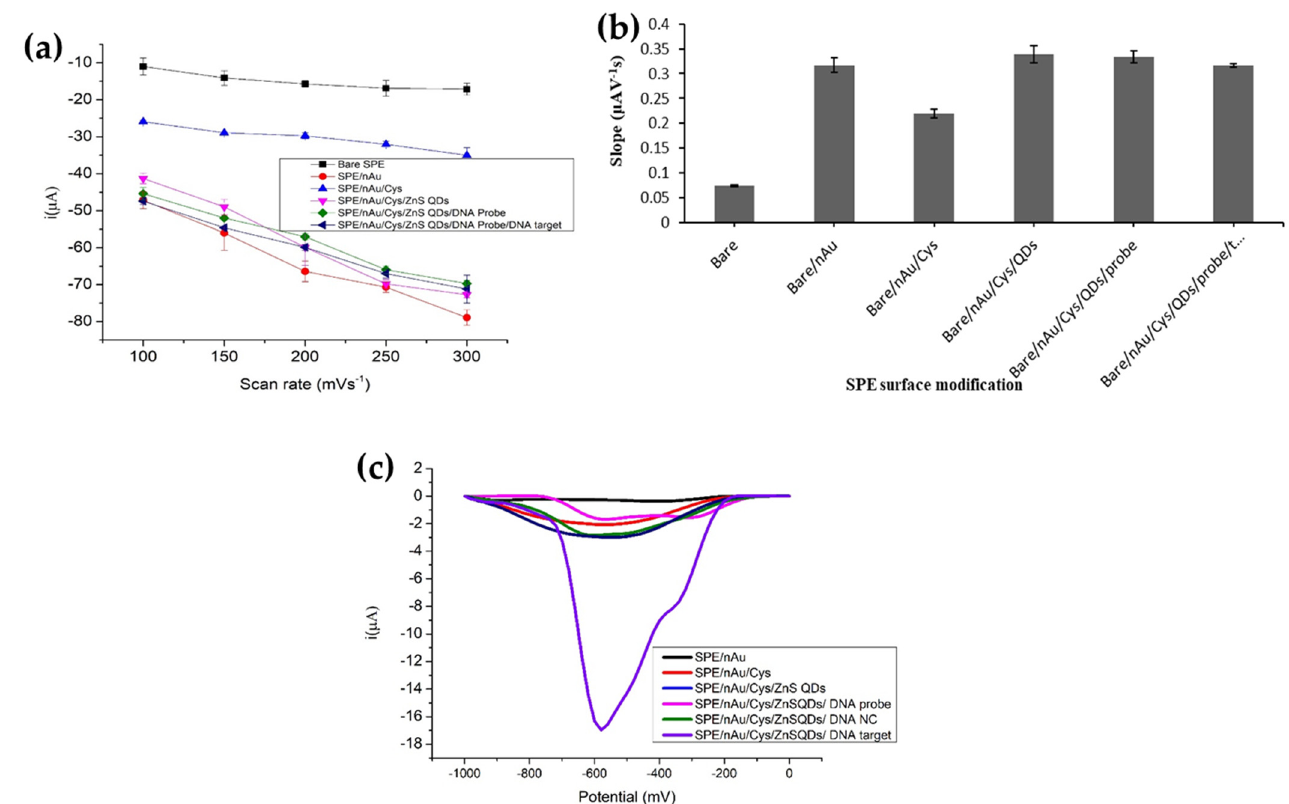
Figure 2. ( a ) The electron transfer rates estimated from the Randles–Sevcik equation for bare SPE and SPEs modified with AuNPs, cysteamine linkers, ZnS QDs semiconducting nanoparticles and DNA molecules by using 1 mM AQMS redox indicator. ( b ) The sensitivity dependent AQMS i pc response at each extended layer on the SPE at scan rate range between 30 mVs − 1 and 300 mVs − 1 in 0.01 M PBS at pH 7 containing 1 mM AQMS and 0.1 M KCl. ( c ) The DPV response of SPE after every modification with AuNPs, cysteamine, MPA-ZnS QDs, DNA probe, target DNA and non-complementary DNA and 1 h AQMS intercalation duration. The DPV measurement was conducted in 0.01 M PBS solution containing 0.1 M KCl at a scan rate of 100 mVs − 1 .